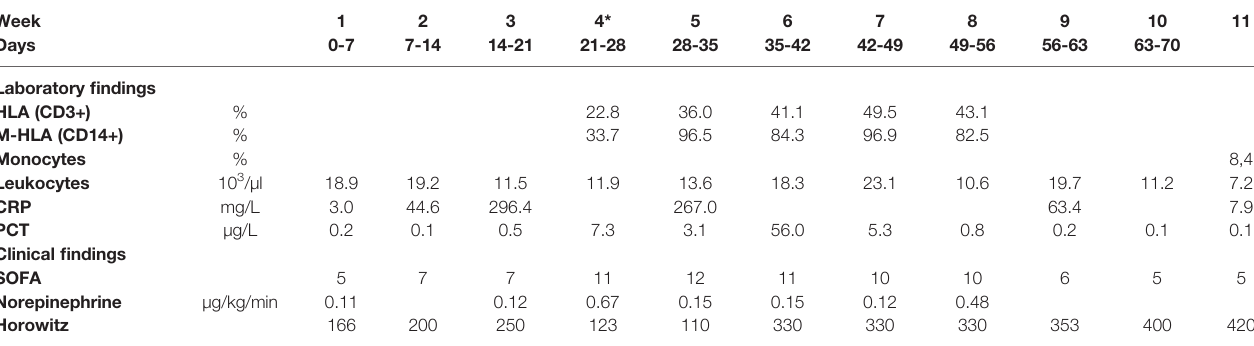
TABLE 1 | Clinical fi ndings and laboratory markers of the patient after ICU admission in our ARDS center.